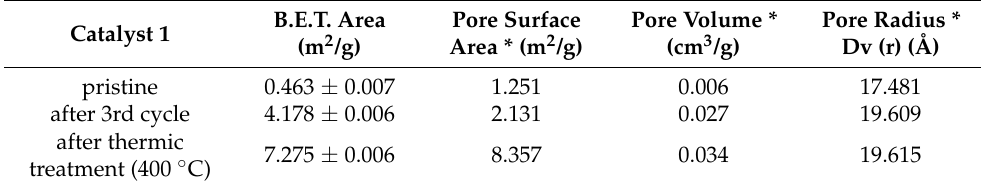
Table 1. The pore structure parameters of catalyst 1